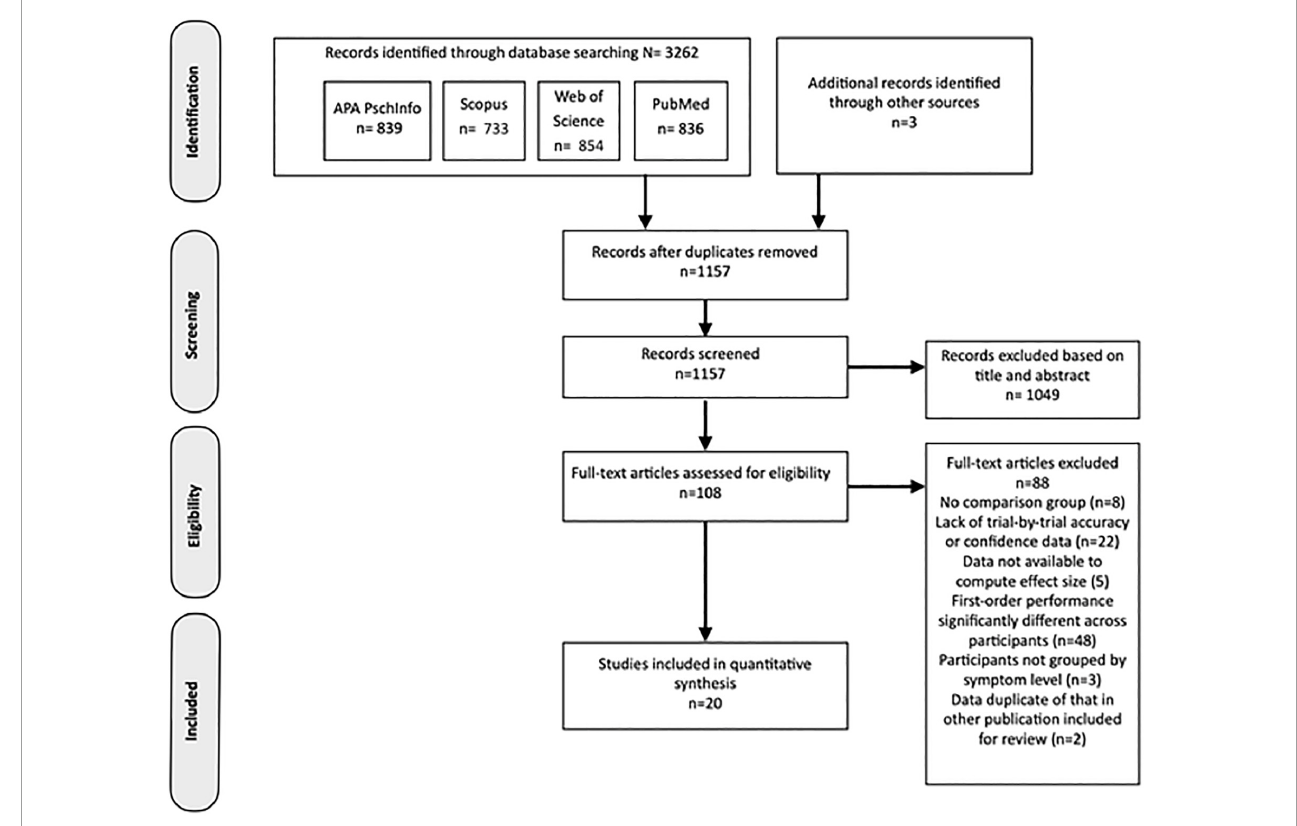
FIGURE2 PRISMA flowchart representing the process producing the final selection of studies included in the